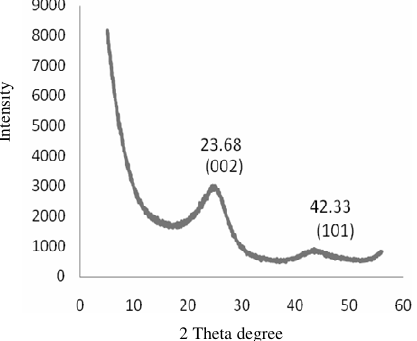
Figure 4. X-ray diffraction pattern of sooth obtained from the combustion of kerosene